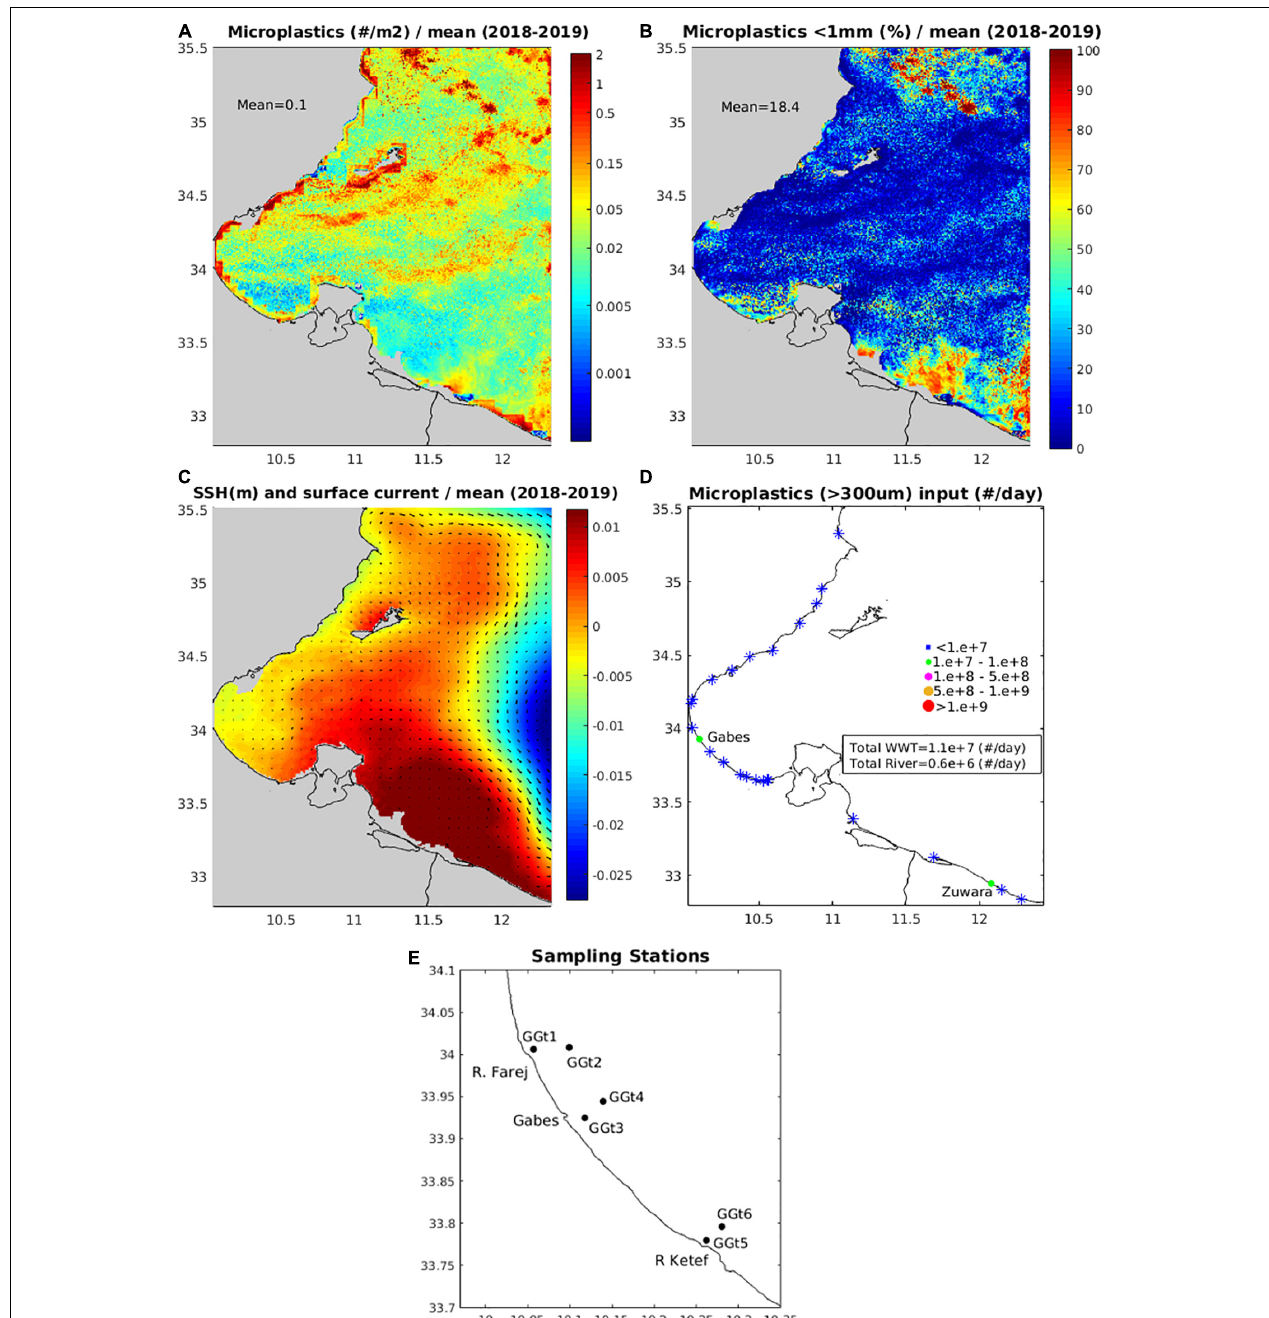
FIGURE 6 | Mean (2018–2019) simulated (A) microplastics concentration (items/m 2 ) (B) microplastics < 1 mm (%), (C) surface current and sea surface height (m) and (D) sources of microplastics (items/day) from cities wastewater discharge and river runoff, (E) sampling stations in Gulf of Gabes.